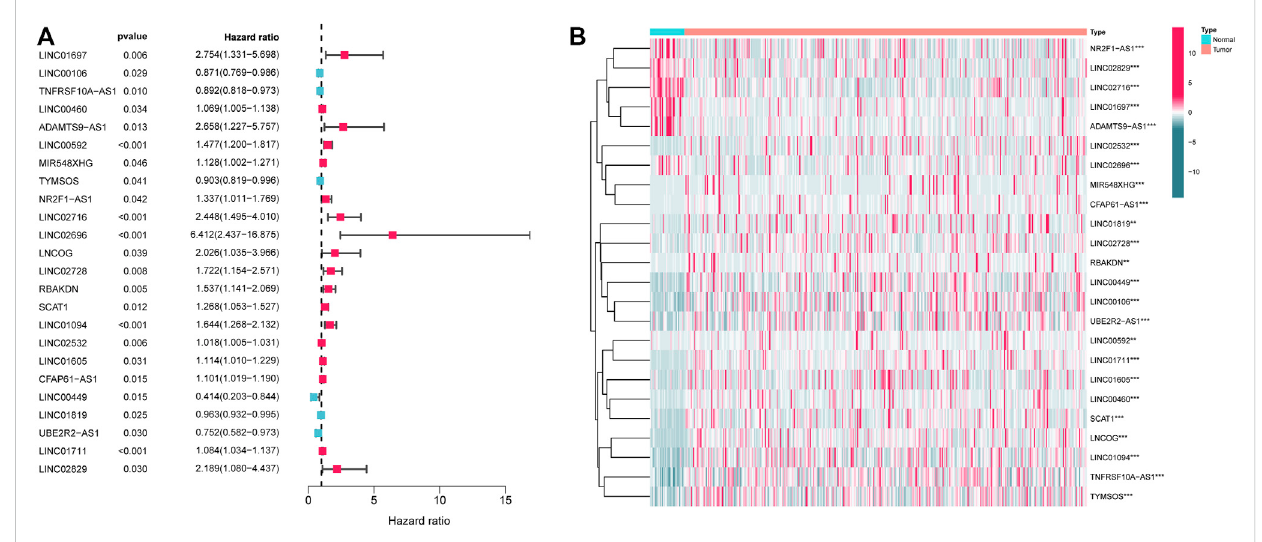
FIGURE 2 Screening with AMMLs. (A) Forest plot of AMMLs linked to STAD OS. (B) Heatmap of differential expression of AMMLs linked to STAD OS. AMMLs, Amino acid metabolism-related LncRNAs; STAD, Stomach adenocarcinoma; * p < 0.05; ** p < 0.01; *** p <